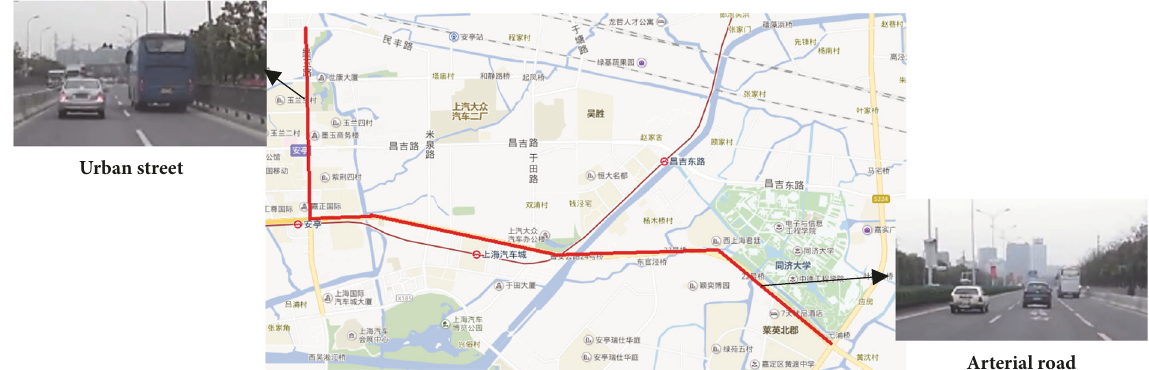
Figure 4: Test route and